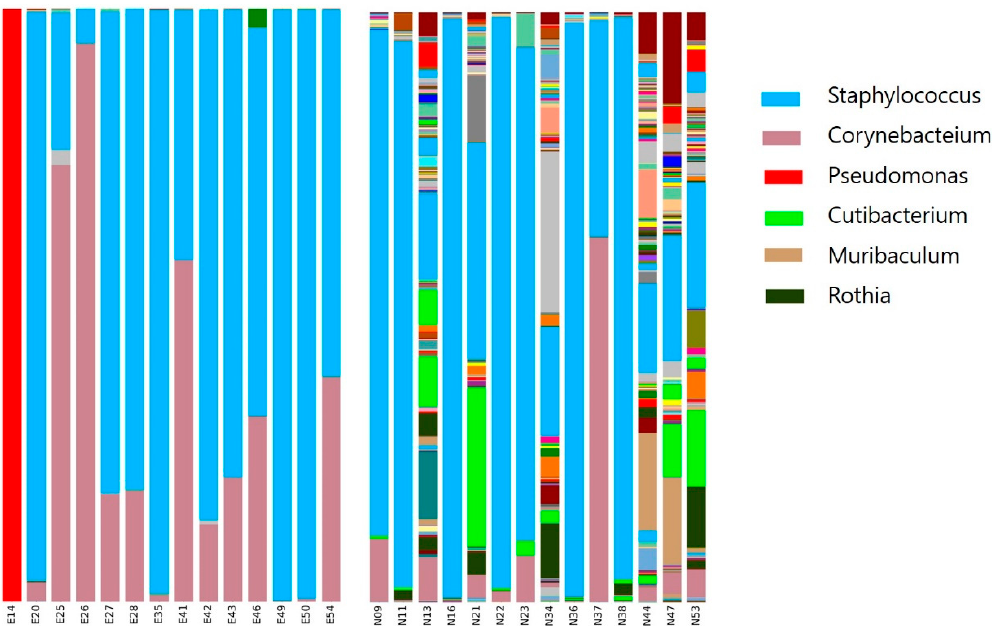
Figure 2. Taxonomic analysis at the genus level. E, external otitis; N, normal healthy control; number, sample number.